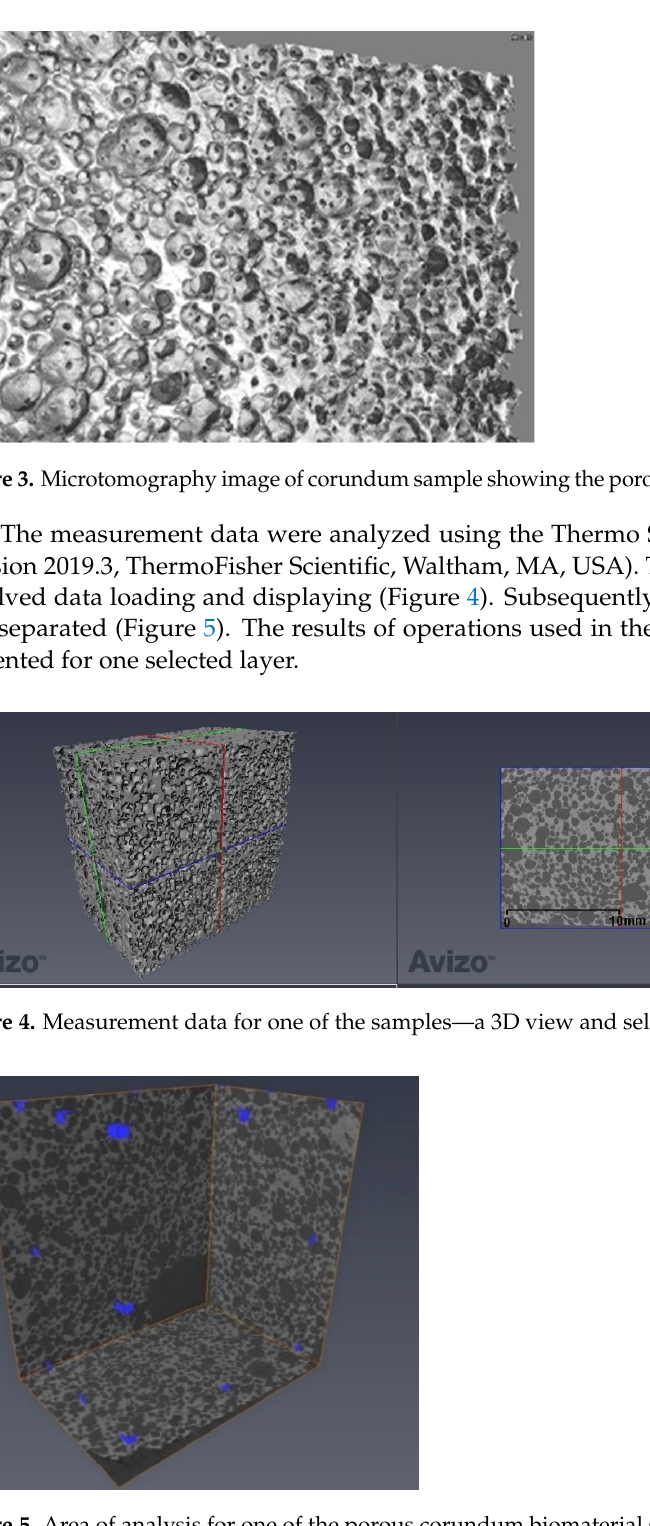
Figure 5. Area of analysis for one of the porous corundum biomaterial samples.